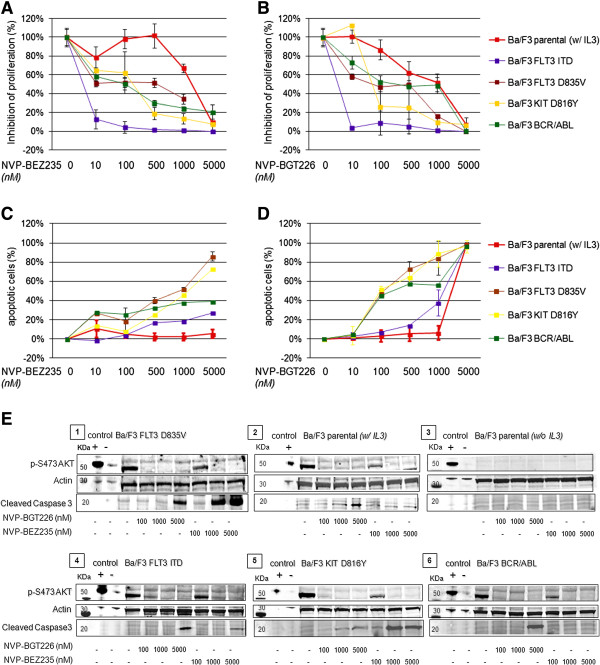
Mutant-tyrosine kinases sensitize Ba/F3 cells to dual PI3K/MTOR inhibition. Ba/F3 cells transfected with KIT D816Y, FLT3 ITD, D835V or BCR-ABL1 isoforms were exposed to NVP-BEZ235 (A) or NVP-BGT226 (B) in a dose-dependent manner. Dual PI3K/MTOR inhibition results in transfectant- and inhibitor-specific inhibition of cellular proliferation (XTT assay) with a higher sensitivity of cells transfected with leukemia-driving mutant-TK (KIT, FLT3, ABL1) isoforms compared to the (IL3-stimulated) parental cell line. When setting induction of apoptosis as the experimental endpoint, NVP-BEZ235 (C) was less effective compared to NVP-BGT226 (D), in all tested transfectants. IC50s, estimated by linear dose regression analysis, are provided along with several more transfectants in Table 1. (E) On the protein level, IL3-stimluated or mutant-TK Ba/F3 transfected cells show similar potent AKT dephosphorylation of Ser473 but cell strain specific cleavage of caspase 3 upon NVP-BGT226 or NVP-BEZ235 exposure. Parental, cytokine-depleted Ba/F3 cells do not express phosphorylated AKT and neither NVP-BGT226 nor NVP-BEZ235 induces cleavage of caspase 3.